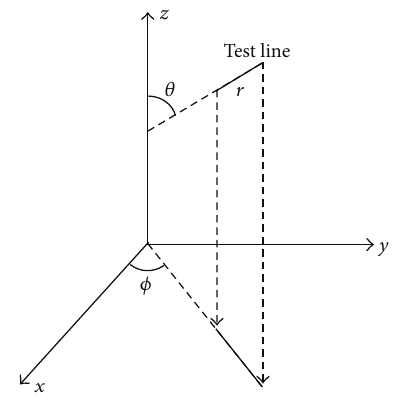
Figure 4: Specification of orientation in 3D